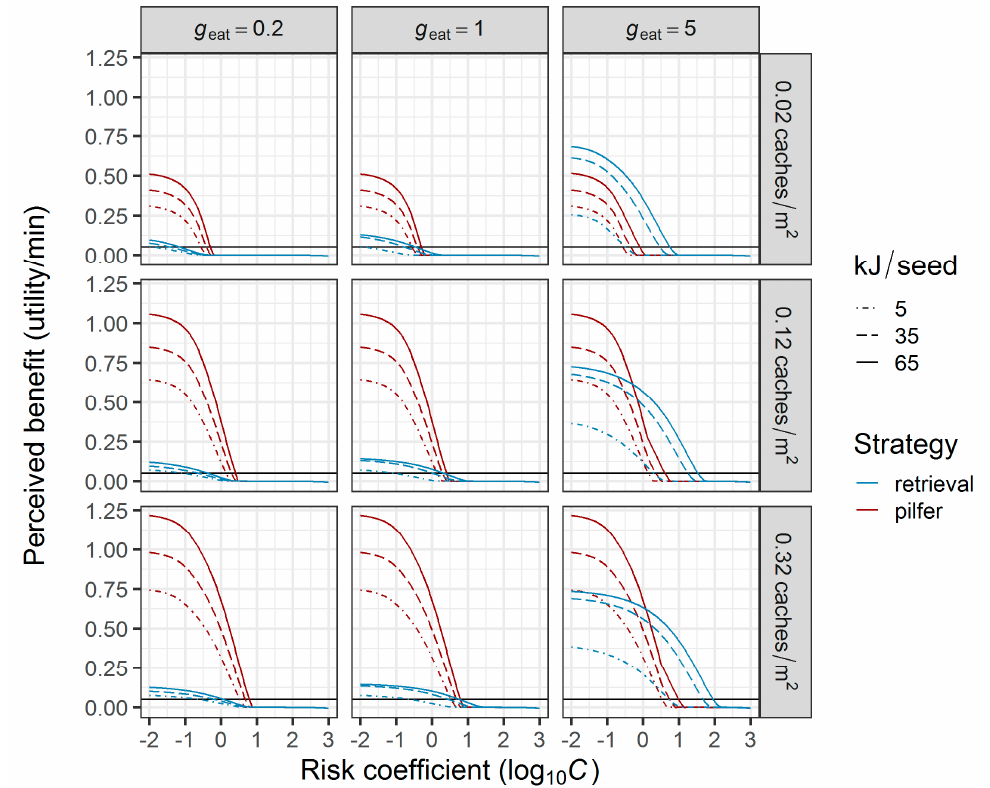
Figure 1. Maximum perceived benefit of foraging (utility) as a function of the perceived riskiness of the foraging location ( x -axis), the value of cached seeds (line styles), cache density (rows), and forager condition (columns; hunger increases from left to right). Colors show results for a forager that recovers its own caches (blue) versus pilfering caches made by other animals (red). Curves show the optimal results under a given set of conditions. The horizontal black line in each panel indicates a hypothetical giving-up threshold, below which animals will stop exploiting the current location and move elsewhere.